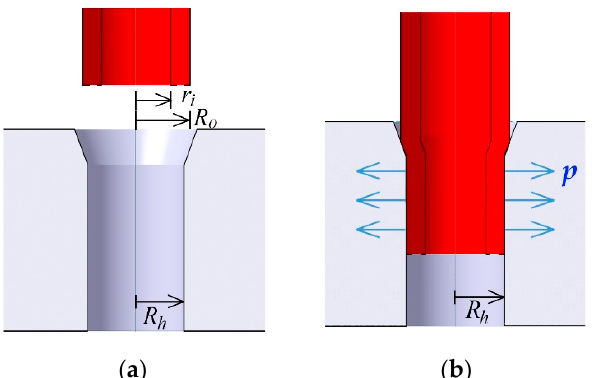
Figure 1. The conceptual illustration using an interference pressure connection. ( a ) before and ( b ) after interconnection. R o is the outer radius of the capillary, R h is the radius of the microhole, and r i is the inner radius of the inserted capillary. p indicates the interference pressure.